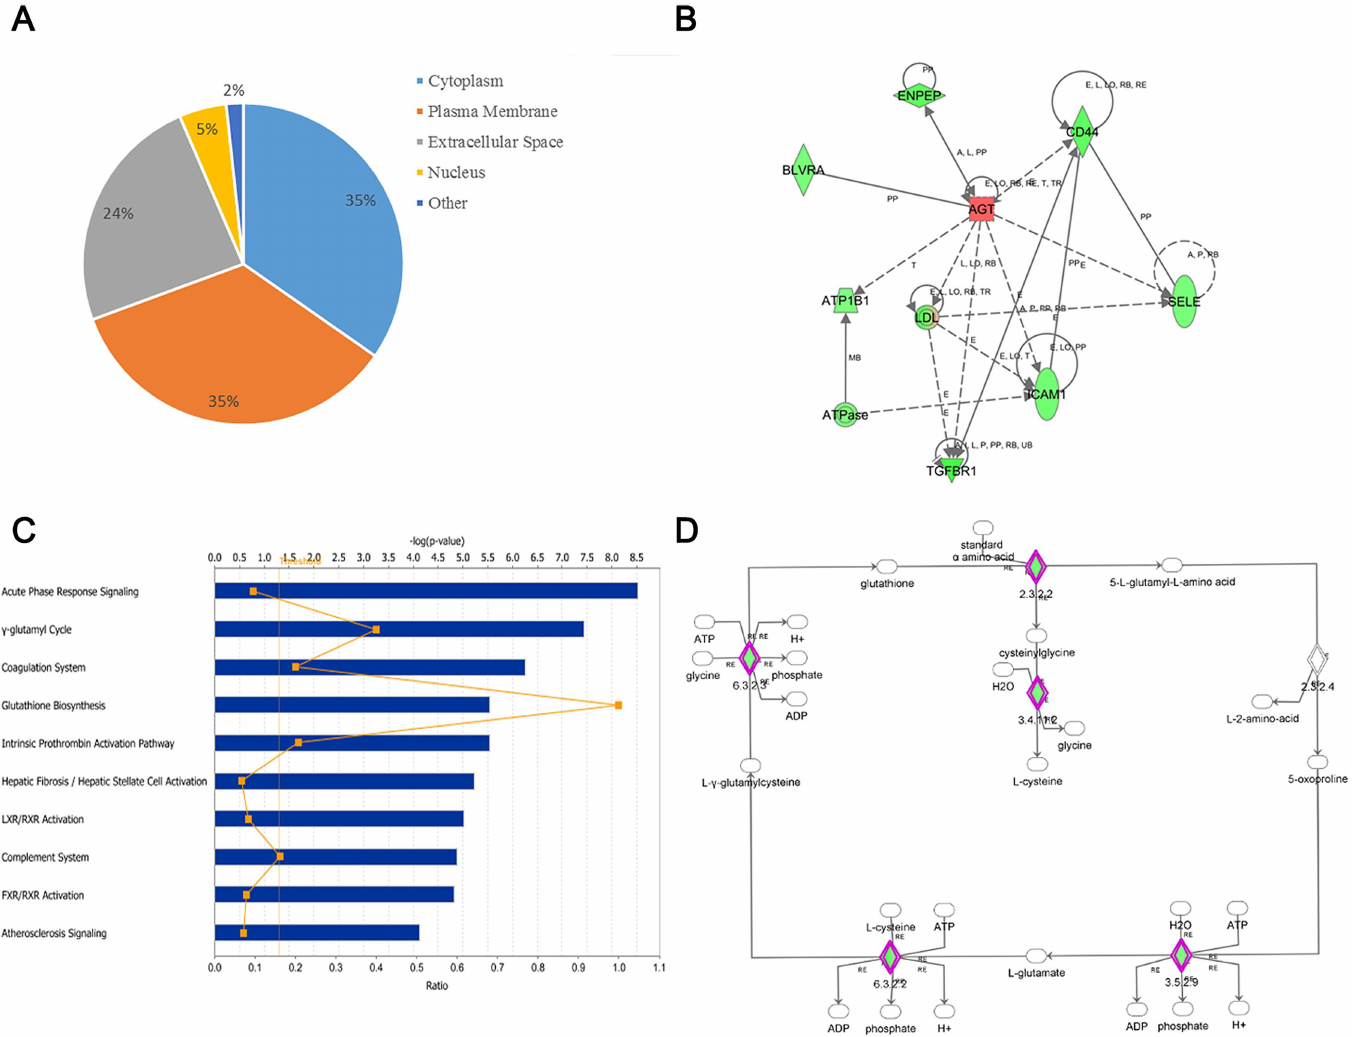
Fig 4. Functional analysis of the protein changes induced by the prazosin treatment. A) Subcellularlocation. B) AGT network. C) Top ten canonical pathways. The y axis shows the negative log of the p value. D) γ –glutamyl cycle pathway. The moleculemarked in red is the protein identifiedin this